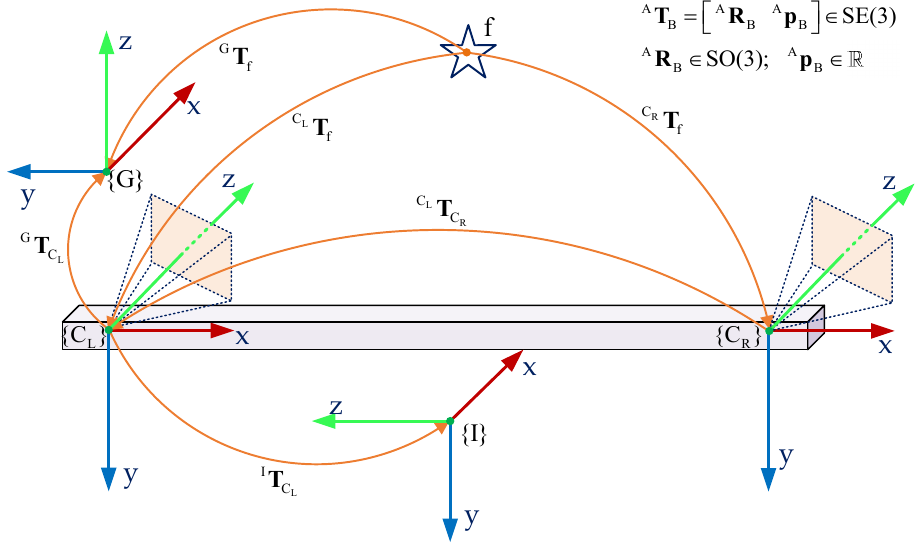
Figure 3. The transformations between the global frame { G } , Inertial Measurement Unit (IMU) frame } , and left camera reference frame { C { I } , right camera frame { C R navigation coordinate. f illustrates the position of a visual feature. A T B = homogeneous transformation from frame B to frame A on SE ( 3 ) , where R is the rotation matrix on SO ( 3 ) and p is the